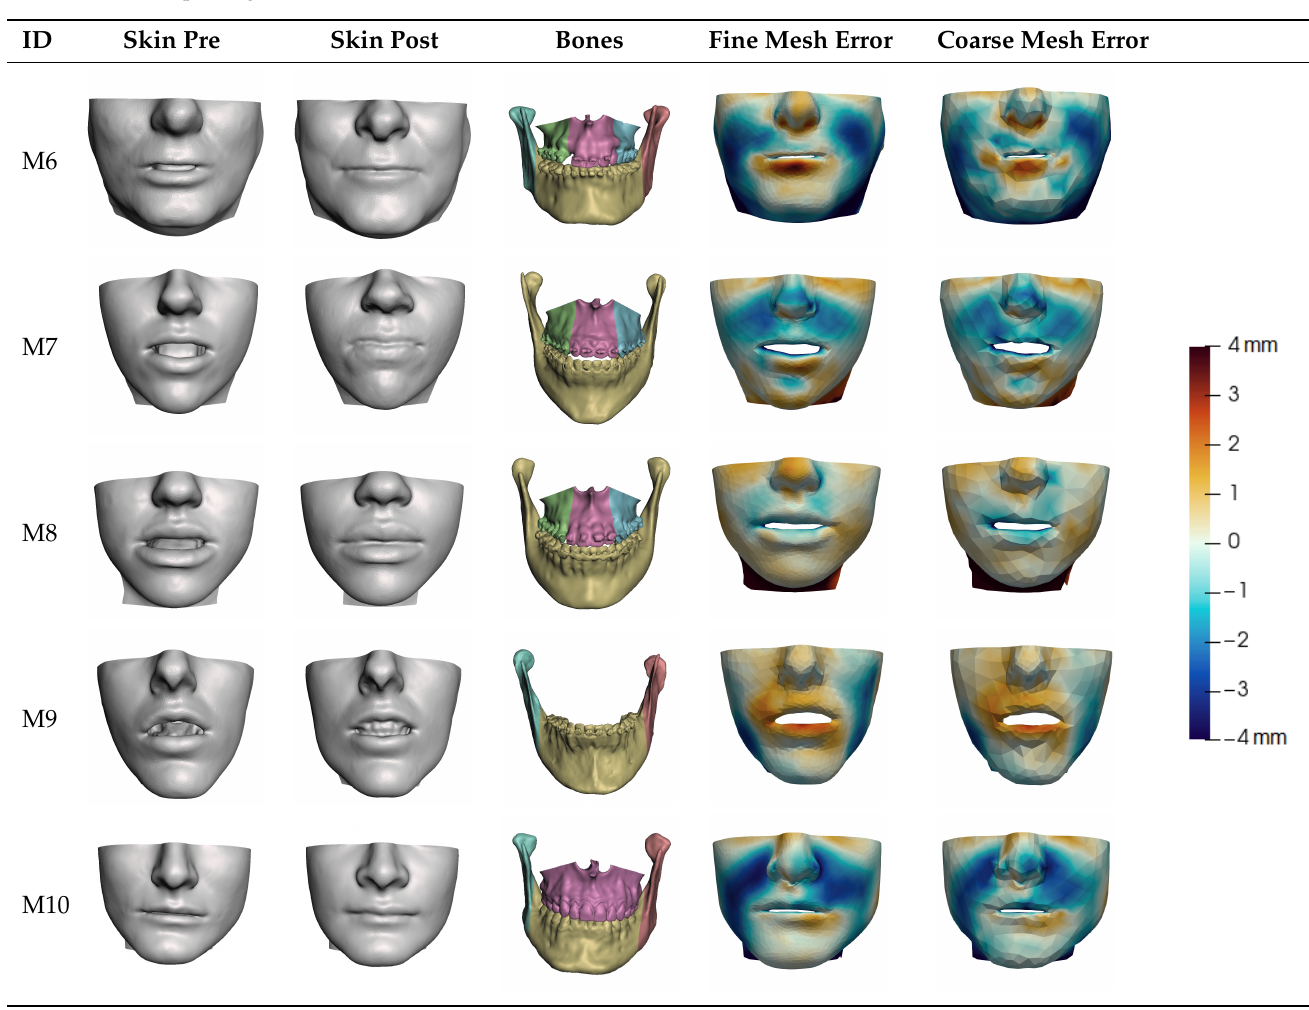
Table 3. Simulation results for patients M6 to M10. From left to right: pre-operative scan, post-operative scan, bone fragments produced during surgery, simulation error using a fine mesh, and simulation error using a coarse mesh. Scale of the color maps ranges from − 4 mm to 4 mm.